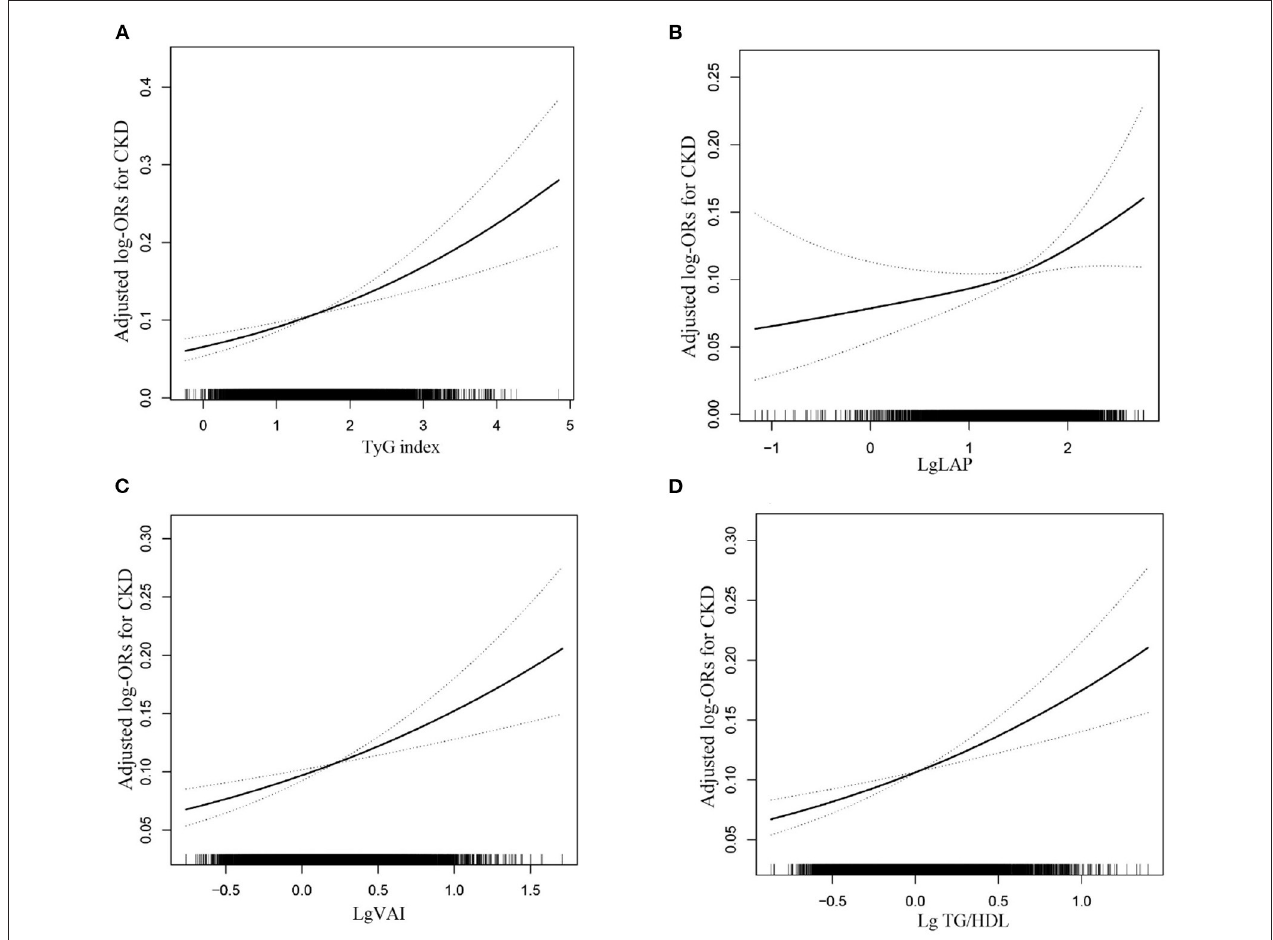
FIGURE 2 | The association between the TyG (A) , LAP (B) and VAI (C) and TG/HDL (D) level and the risk of CKD. The solid line and dashed line represent the estimated values and their corresponding 95% confidence interval, respectively. The adjustment factors included age, sex, BMI, education, physical activity, current smoking, current drinking, SBP, DBP, pulse, Hcy, AST, GGT, LDL-C, Antihypertensive drugs, Antiplatelet drugs, self-reported